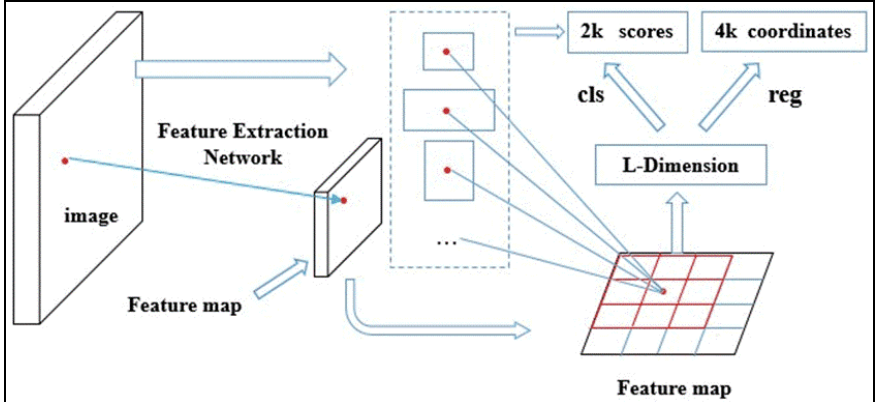
Figure 3. Process of supervised training. The input are images and labels, the output are scores and coordinates of regional proposals. The regression layer is used to fine-tune the positions of regional proposals. The regional proposal has an object score can be obtained by the classification layer. We can obtain objects and the location of objects by regression layer and classification layer. We can get candidate window by scores and coordinates of regional proposals.